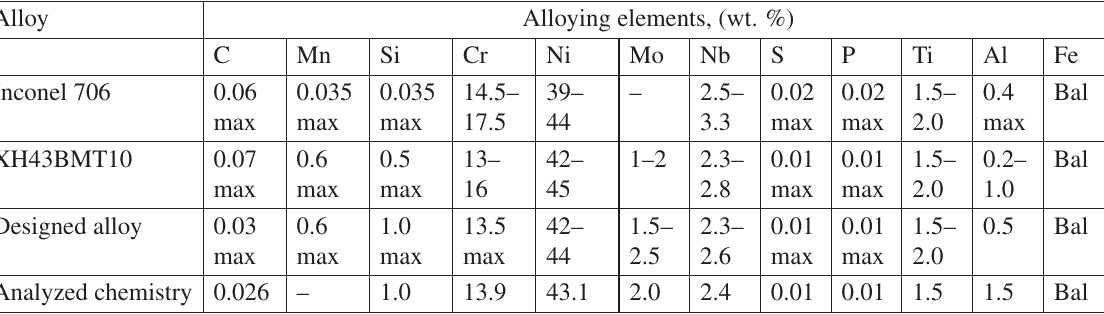
Table 1. Nominal compositions of Inconel 706, XH43BMTI0 and designed superalloy.